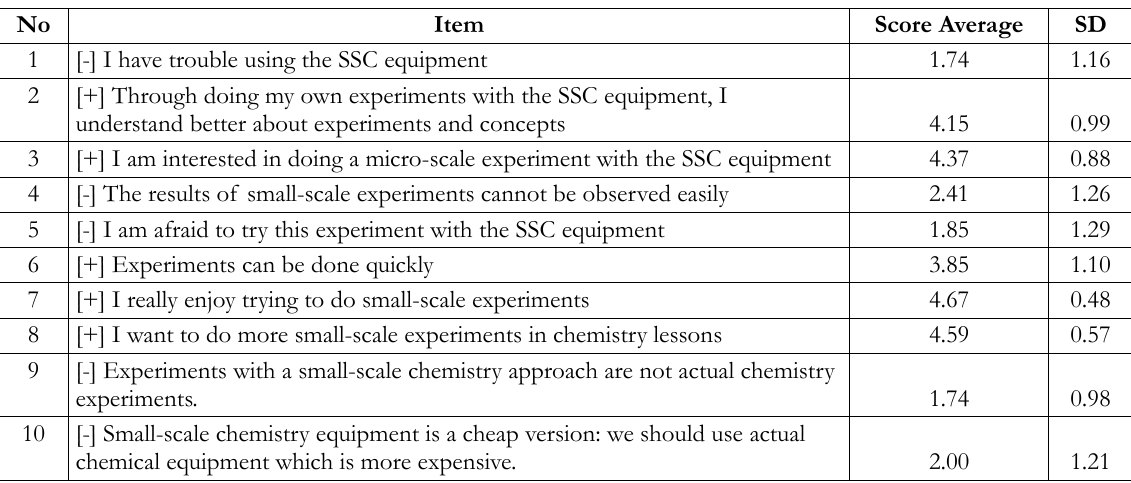
Table 4. Student responses to the implementation of chemistry practicum with a small-scale chemistry approach on acid-base topics (N=